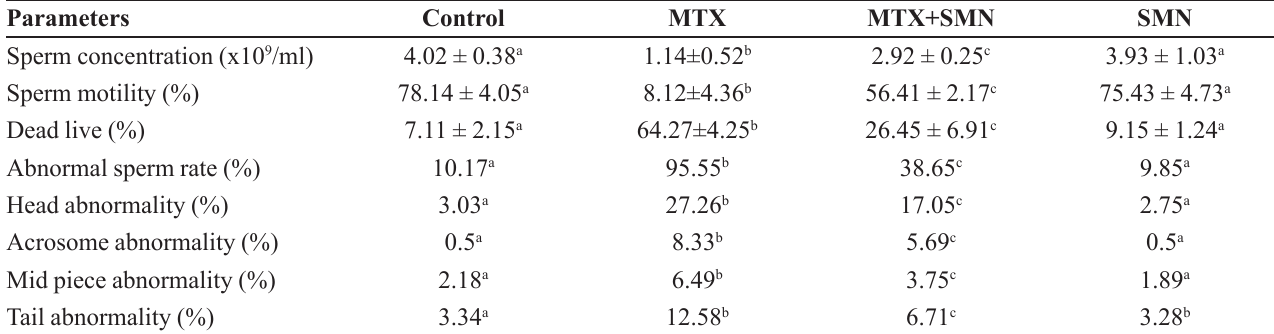
TABLE IV - Effects of MTX and SMN on Spermatological data by study groups